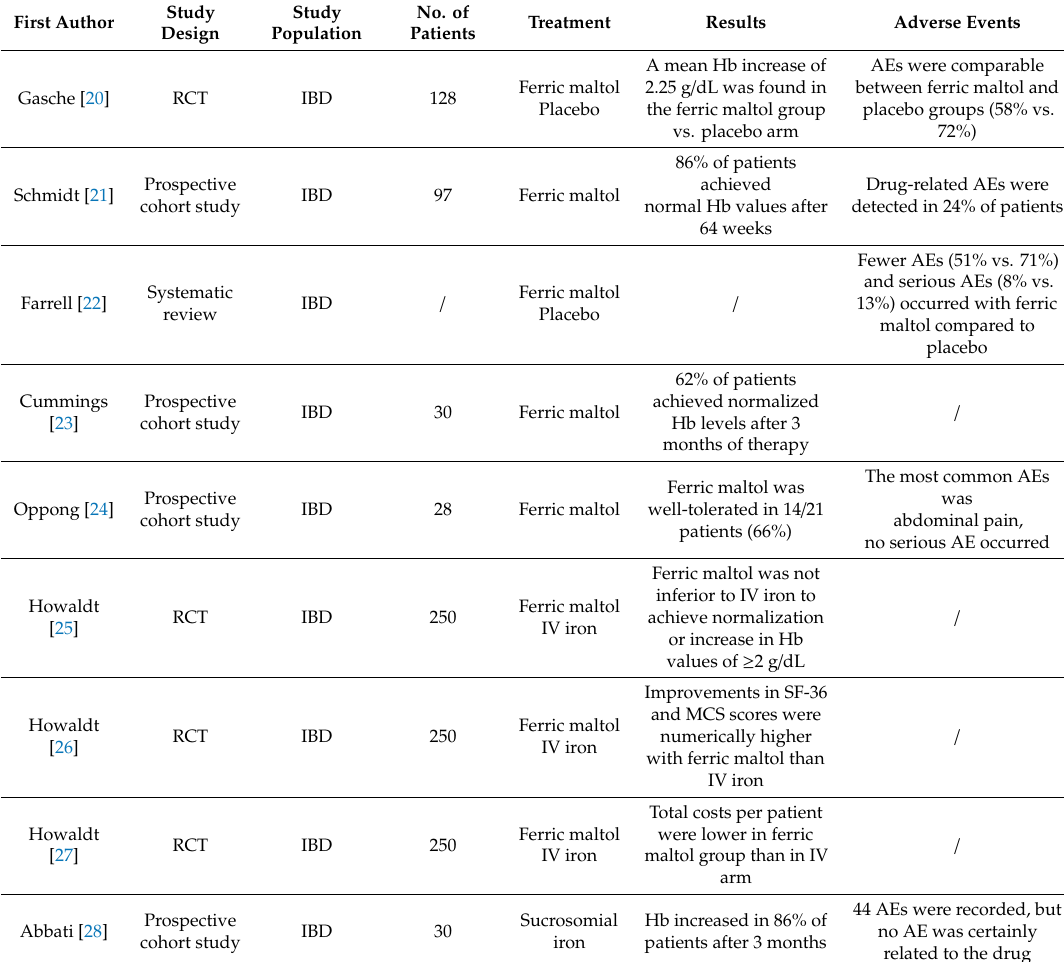
Table 2. Main characteristics of ferric oral iron studies for the treatment of